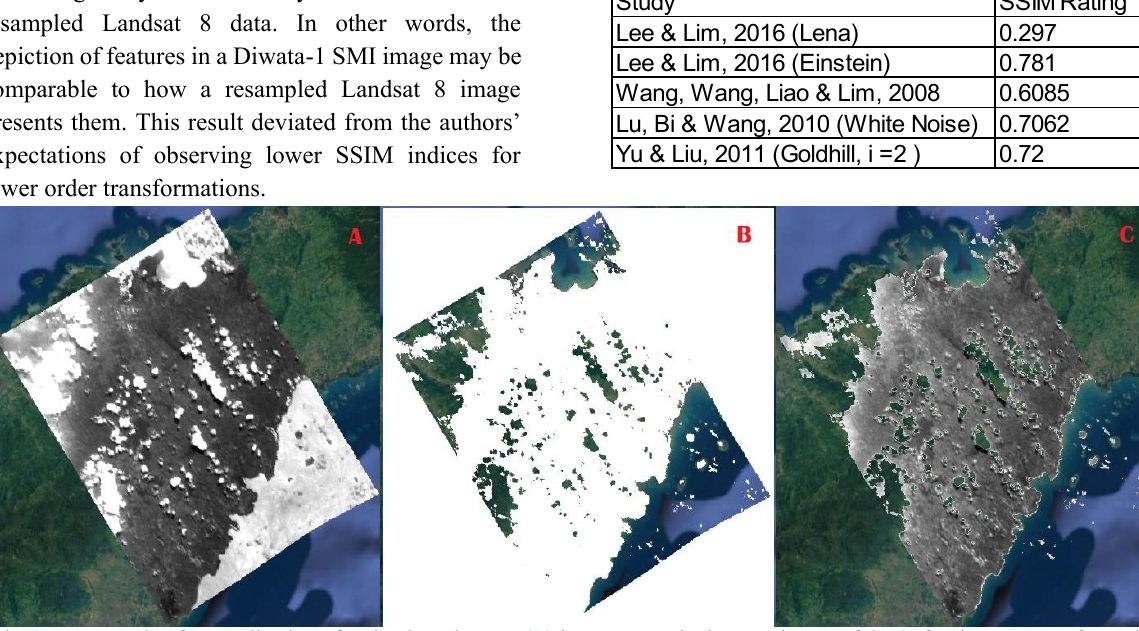
Fig.6. An example of an application of a cloud mask. Item (A) is a processed Diwata-1 image of the Sofronio area, transformed using thin plate spline. Item (B) is its corresponding cloud mask, where the white areas are valued as ‘1’ and the transparent areas (denoting the cloudy areas and the bright water areas) are valued as ‘0’. Item (C) is the resulting output using Raster Calcu lator in QGIS